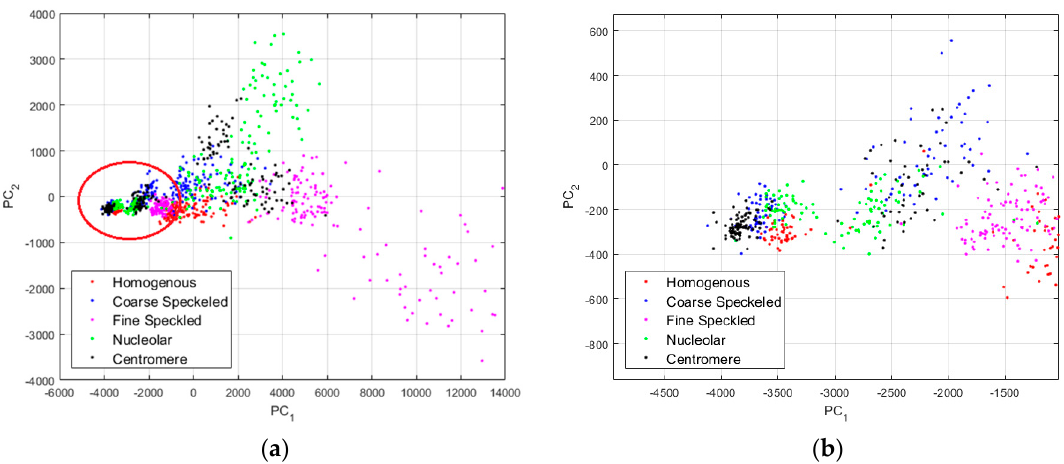
Figure 10. ( a ) Projections of the data from the SNPHEp-2 dataset; ( b ) The zooming of the part surrounded by the red circle in ( a ).